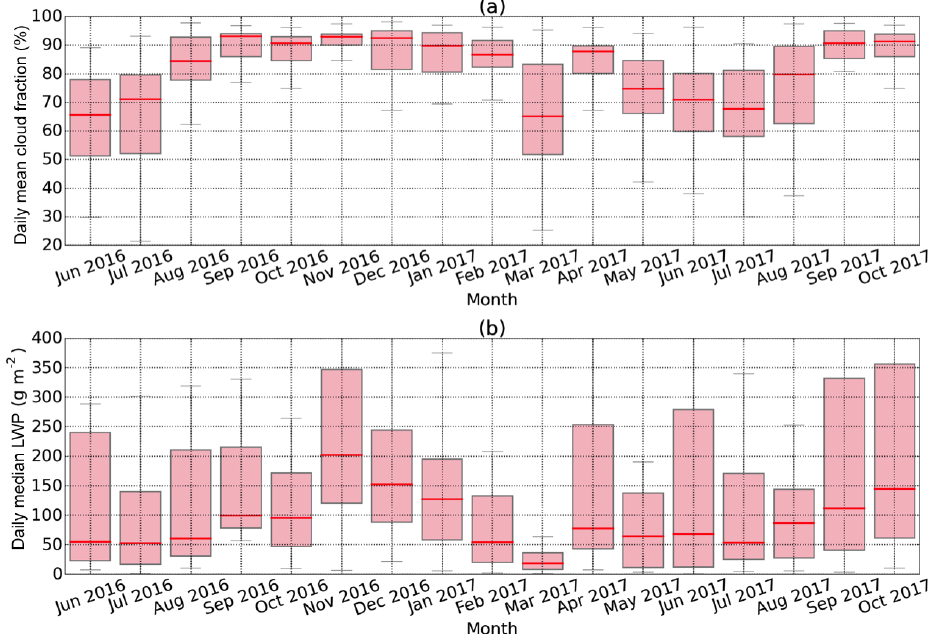
Figure 6. Monthly boxplots of (a) daily mean Total Sky Imager cloud fraction and (b) daily median MWR best-estimate LWP for each month in the LASIC